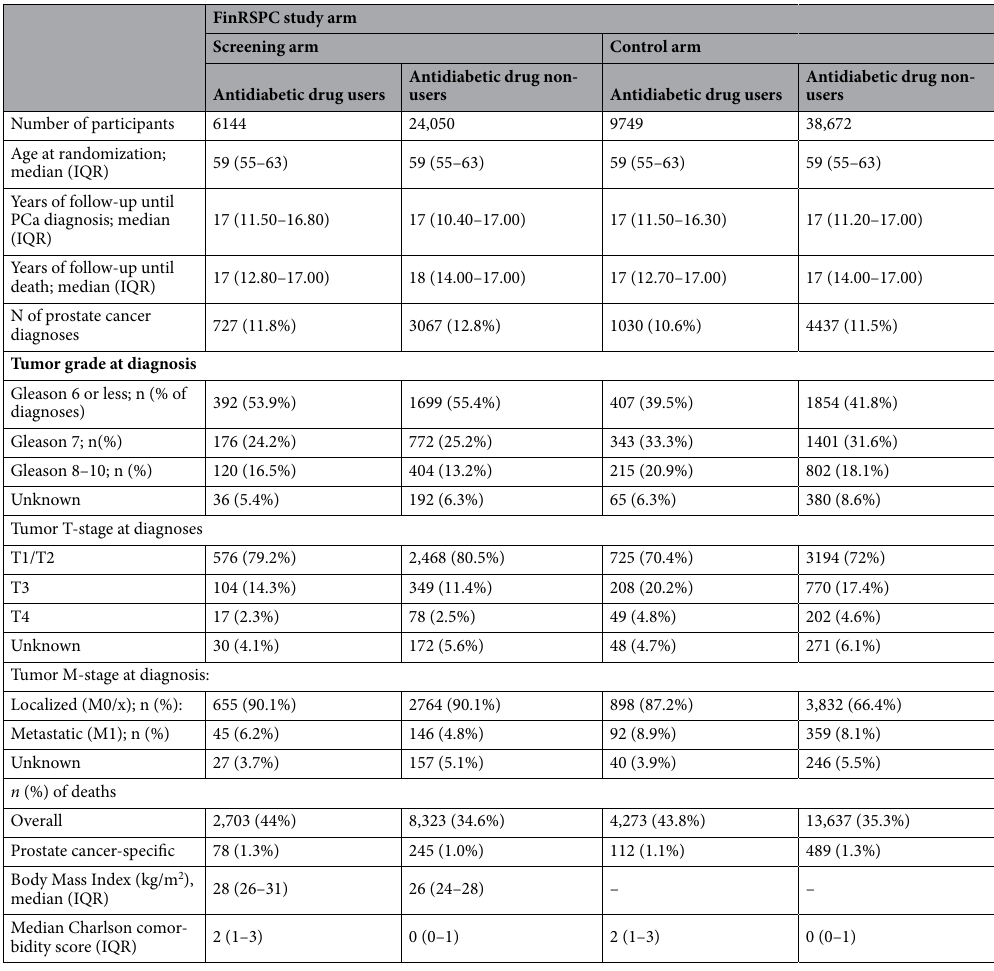
Table 1. Descriptive characteristics. Study population of 78,615 men from the Finnish Randomized Study of Prostate Cancer